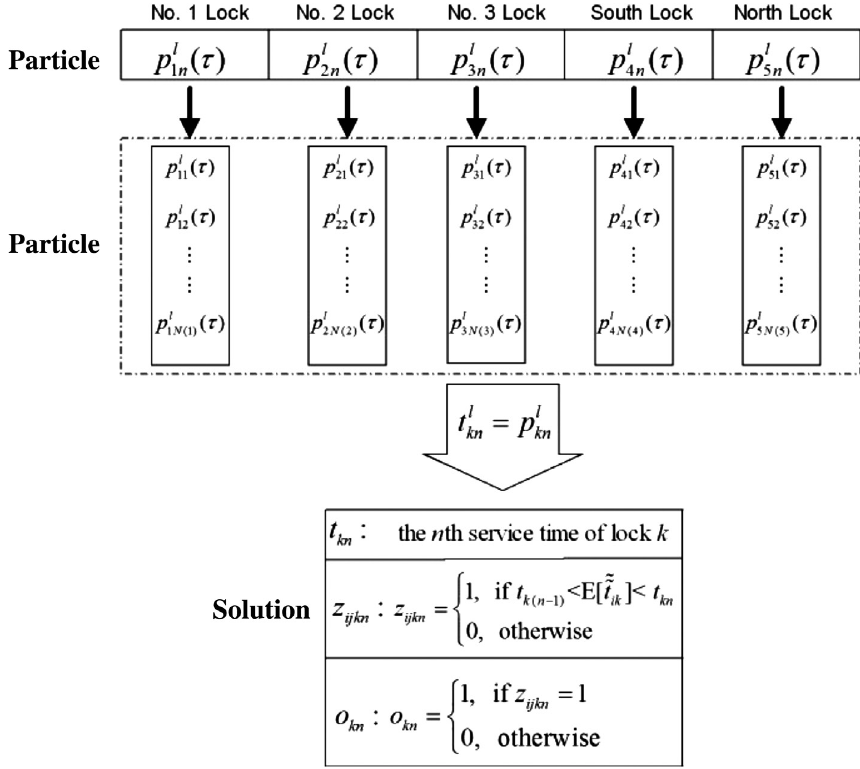
Fig. 8. Decoding method and mapping between PSO particles and